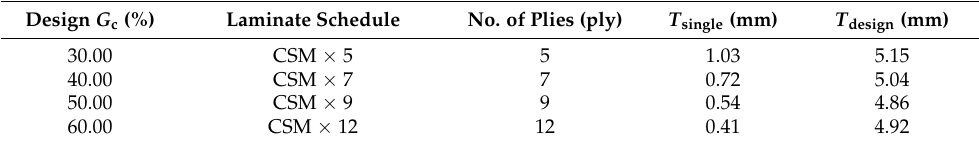
Figure 4. Designs of combined-material specimens produced using chopped strand mat and wo- ven roving. ing. Table 2. Design details of combined-material specimens. Table 1. Design details of single-material specimens.